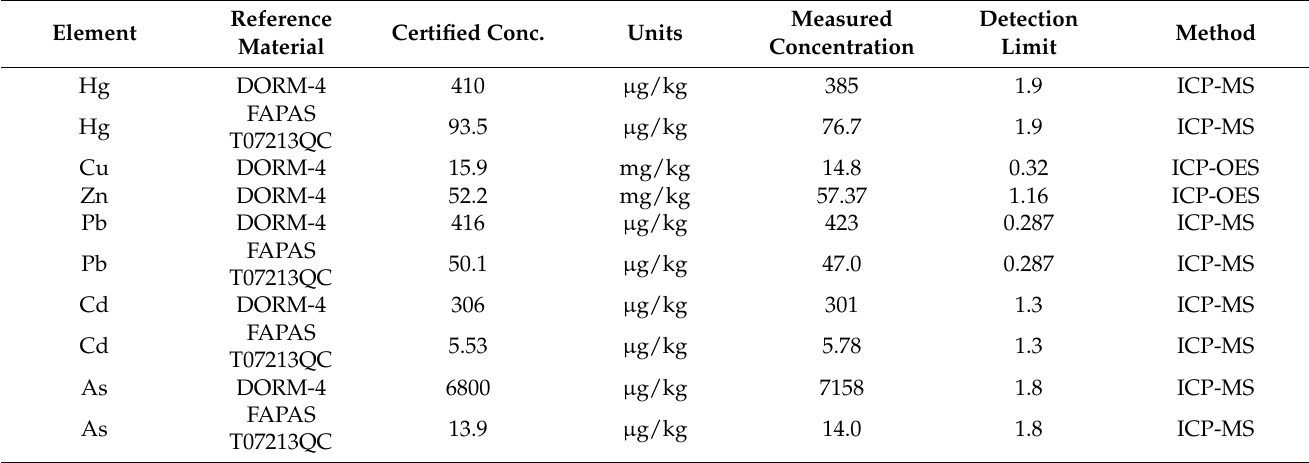
Table 2. Certified concentration and measured values for reference material DORM-4 and FAPAS T07213QC by method.